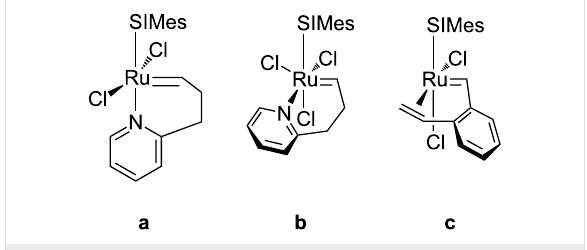
Scheme 3: Ruthenium catalysts, bottom-bound ( a ) or side-bound ( b and c